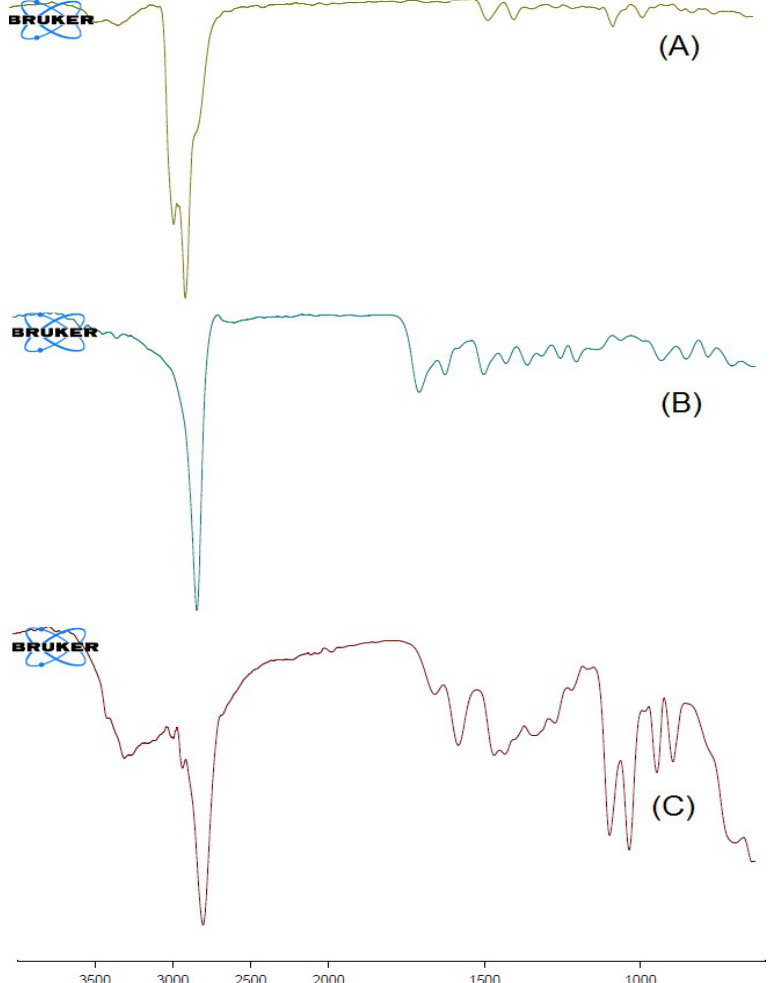
Figure 5. FT-IR spectra of β -SIT ( A ); folic acid ( B ); and β -SIT-Alg/Ch-NPs-FA( C